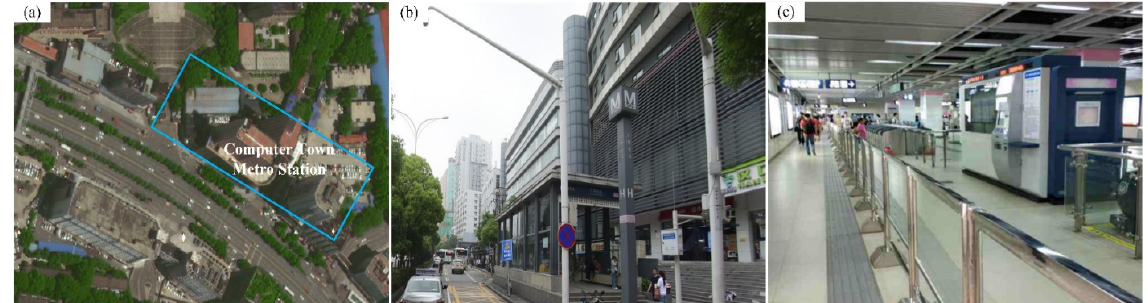
Figure 4. Study area in Wuhan. (a) Location of Computer Town metro station in satellite image; (b) Snapshot of the metro station aboveground; (c) Snapshot of the metro station underground;